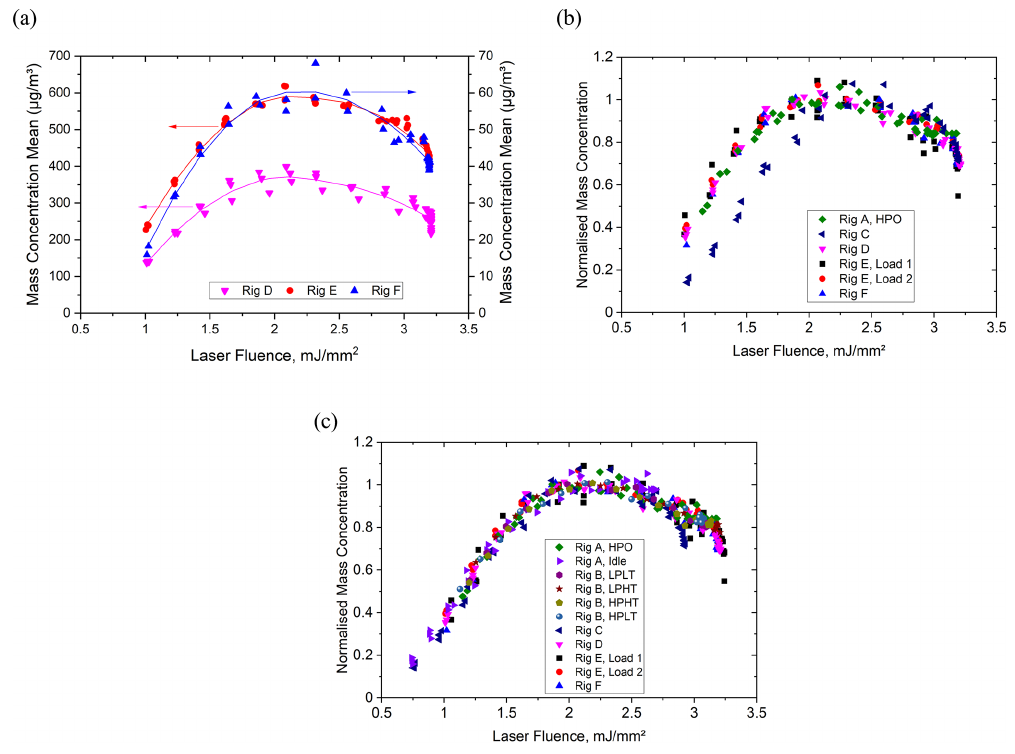
Figure 11. (a) Laser fluence dependence of mass concentration measurements from LII 300 using multiple nvPM sources from diesel- (Rigs D and E, Load 2) and gasoline-fuelled (Rig F) engine exhausts at typical operation conditions. Superimposed are the best-fit curves from the Loess method. (Arrows point at the corresponding y axis.) (b) Normalised mass concentration vs. laser fluences from Rigs A and C to F. Measurements were carried out by the same instrument LII 1 for the kerosene cases (Rigs A, C) as for the diesel and gasoline cases (Rigs D to F). Rig E, Load 1: speed 1200rpm, load 165Nm; Load 2: speed 2200rpm, load 300Nm. (c) Combined data from all rigs with the laser fluence axis of Rig C and Rig E, Load 1, shifted to the left by 0.27 and − 0 . 05mJmm − 2 ,